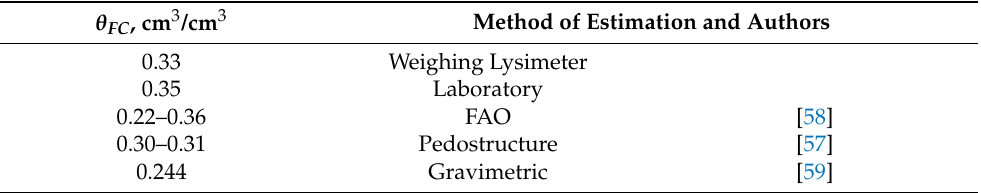
Table 3. Comparison of field water content value obtained in the soil with literature